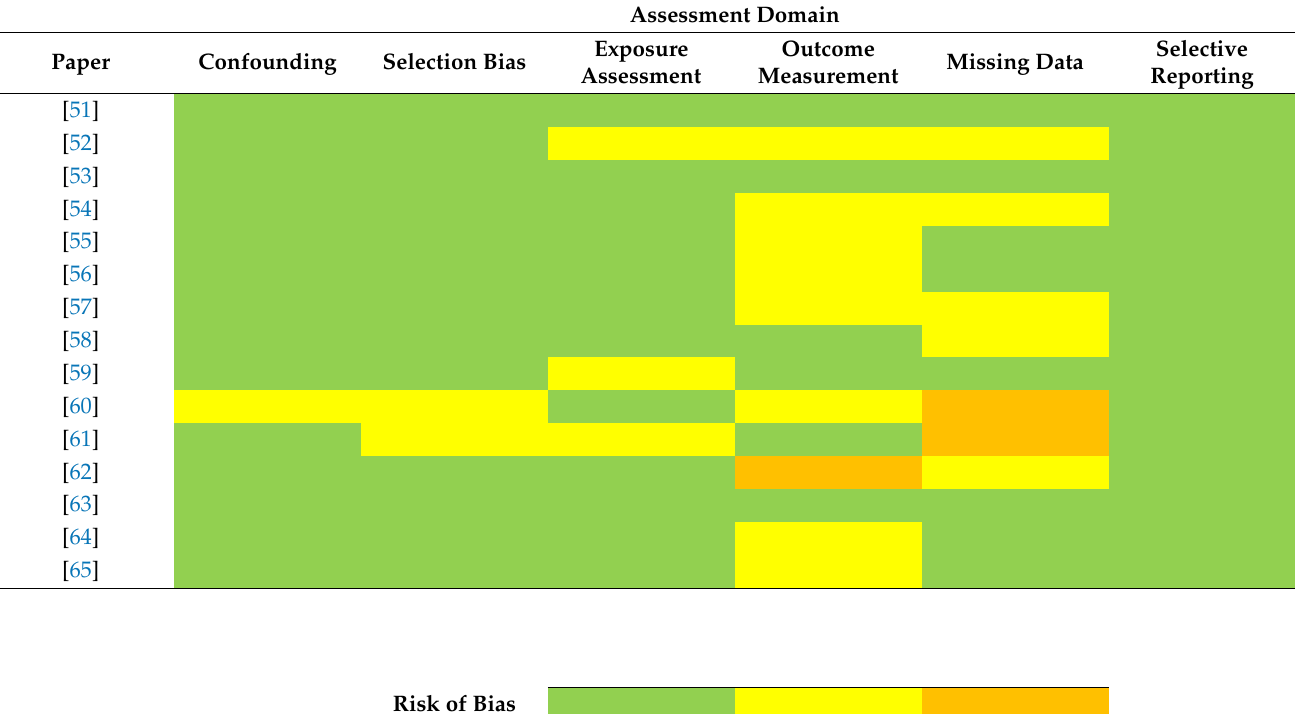
Table 3. Risk of bias assessment heat